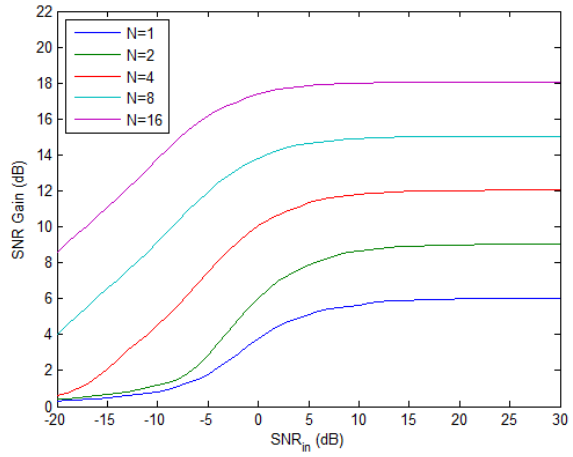
Figure 4. SNR gain vs. input SNR with different number of